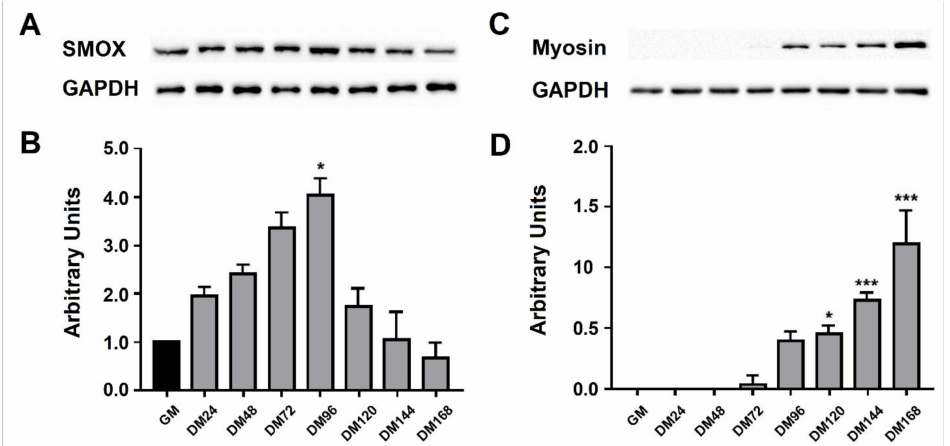
Figure 3. SMOX protein expression profile during C2C12 cell di ff erentiation. Western blot analysis of SMOX ( A ) and Myosin ( C ) proteins on murine C2C12 myoblasts (GM) and myotubes (DM) at di ff erent time points (DM 24–168). Data are calculated relative to the internal housekeeping GAPDH gene,